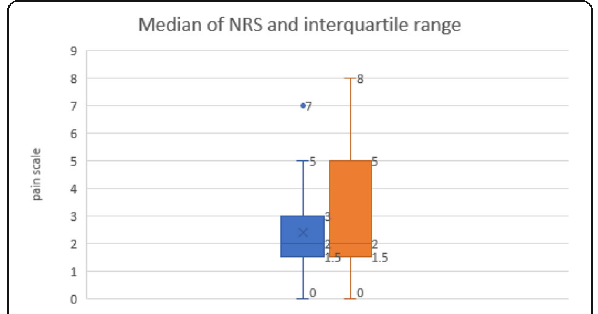
Fig. 1 The median and interquartile range of the numerical rating